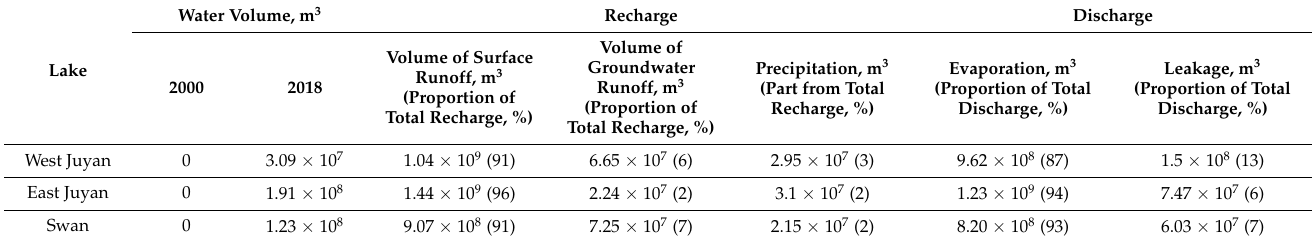
Table 5. Water balance components of West Juyan, East Juyan, and Swan Lakes based on the results of a simulation from 1 January 2000 to 31 December